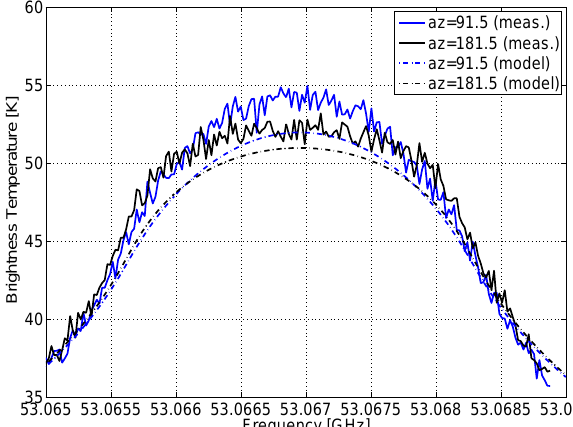
Figure 12. Brightness temperature spectra from the SDR spectrom- eter (solid lines) and simulated from ARTS (dash lines) for two dif- ferent observational